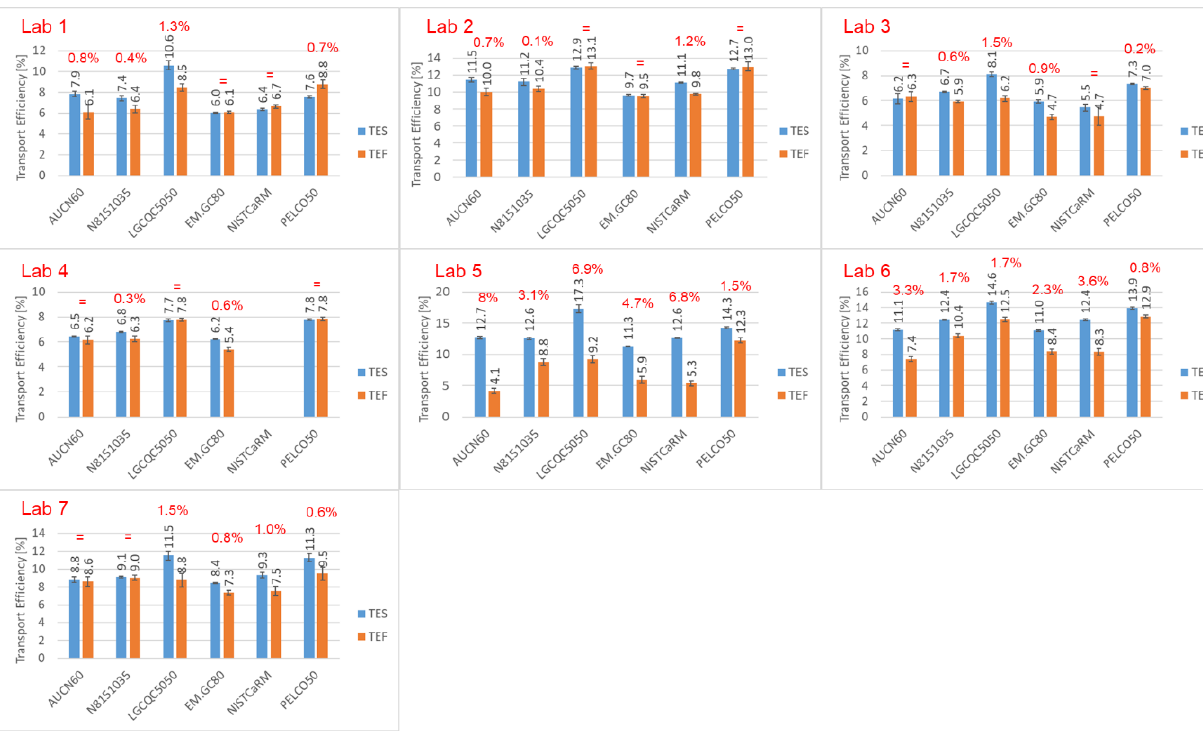
Table 7. Mass concentrations and particle sizes declared on certificate of analysis opposed to those determined in this